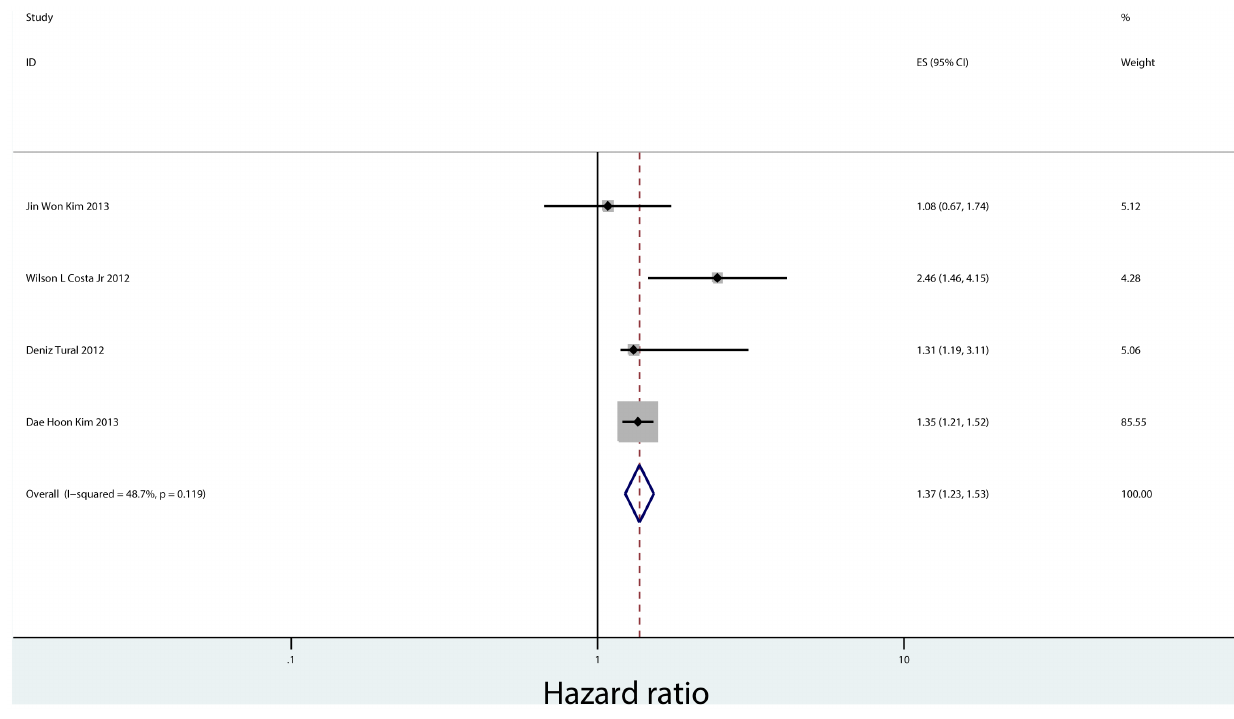
Figure 8. Forrest plot of combined hazard ratio for the association of PNI and DFS in multivariate analysis.